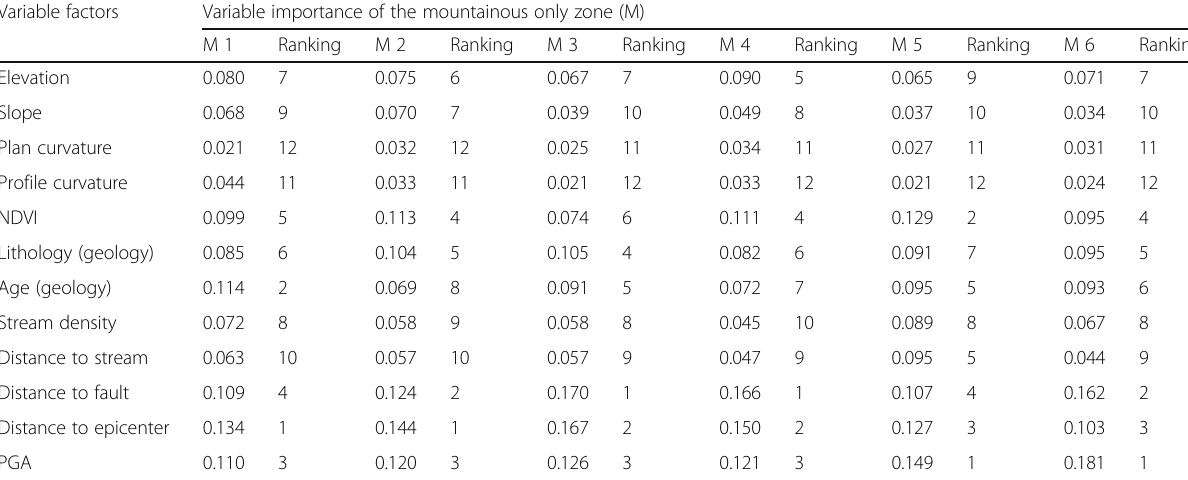
Table 3 Variable importance and ranking for the mountainous only zone (M) Variable